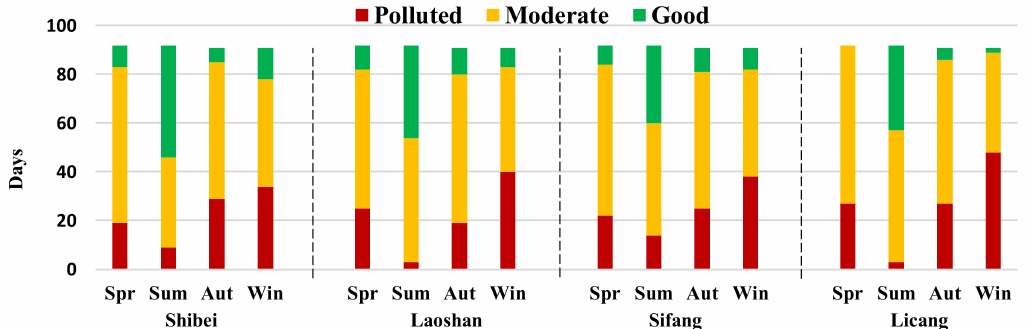
Figure 4. Chart showing the number of days of each level of air quality (AQ).